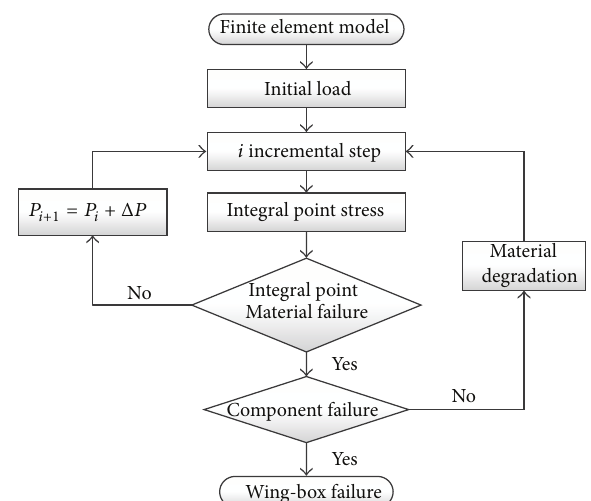
Figure 4: Flow chart of wing-box failure analysis.